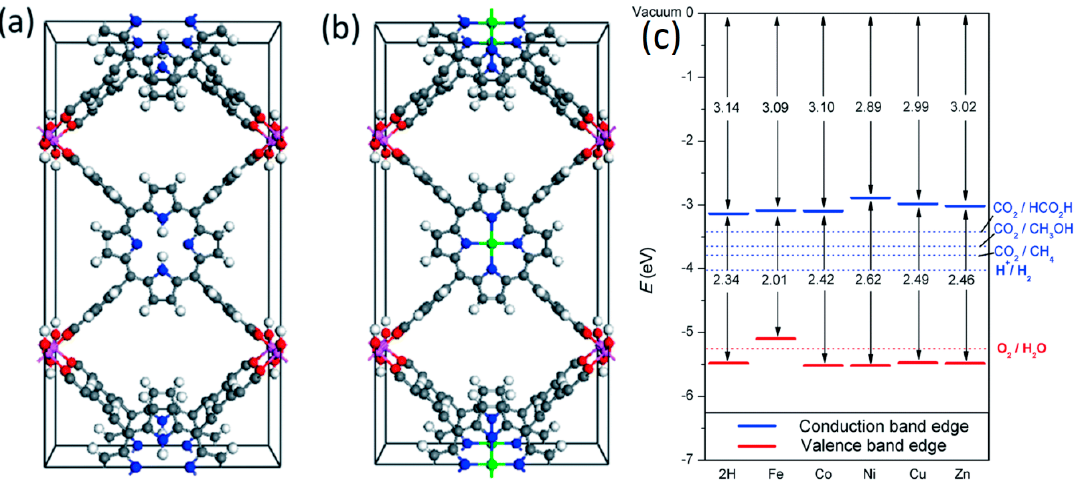
Figure 4. Perspective view of the porphyrin-based metal organic framework (MOF) investigated in this study in ( a ) the protonated case, and ( b ) the metal-substituted case. Color code: gray = carbon, white = hydrogen, red = oxygen, blue = nitrogen, magenta = aluminum, green = transition metal. ( c ) Bandgaps and band edge positions of MOFs with respect to the vacuum level, as calculated with the HSE06 functional. Energy levels corresponding to redox potentials of water splitting and carbon dioxide reduction reactions producing methane, methanol, and formic acid at pH = 7 are also shown with dotted lines. Reproduced from reference [55] published by The Royal Society of Chemistry.